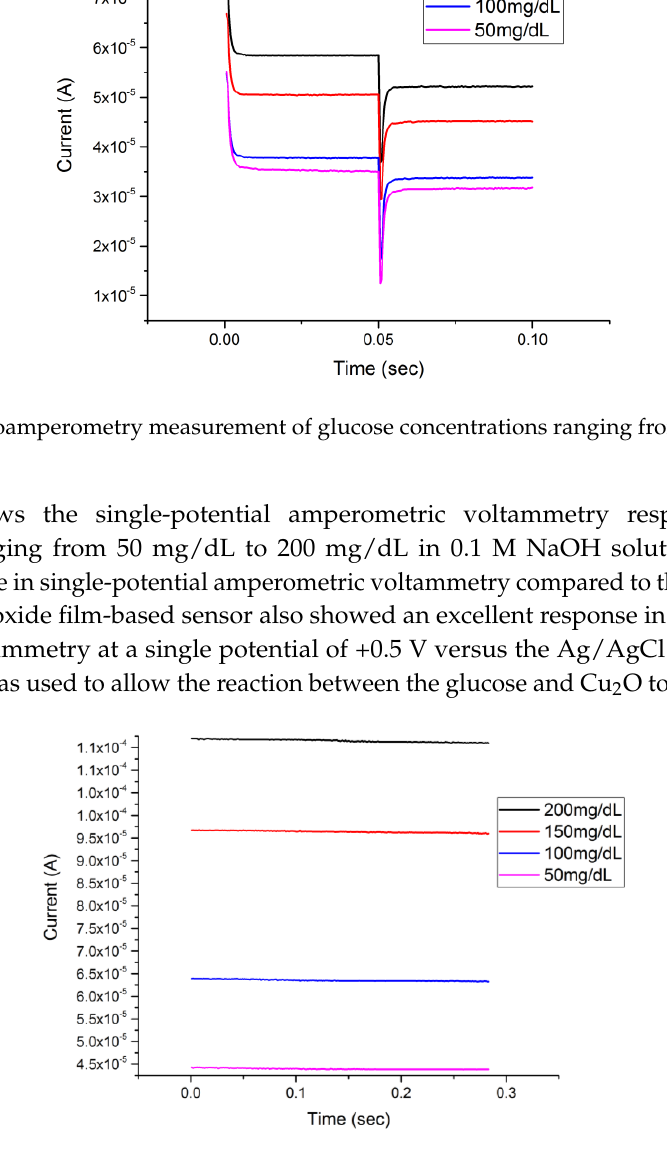
Figure 6. Single-potential amperometric voltammetry measurement of glucose concentrations ranging between 50 mg/dL and 200 mg/dL.